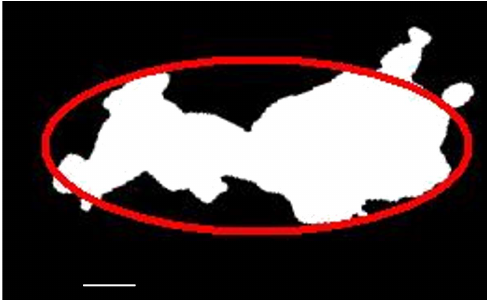
Fig. 6. The compositions of various bubbles merging and overlap- ping each other create bubble clusters. The volume of a best fit ellipse is larger than the actual gas volume. These clusters carry the majority of gas dominating the overestimated computed flux. The white scale bar below is 1cm